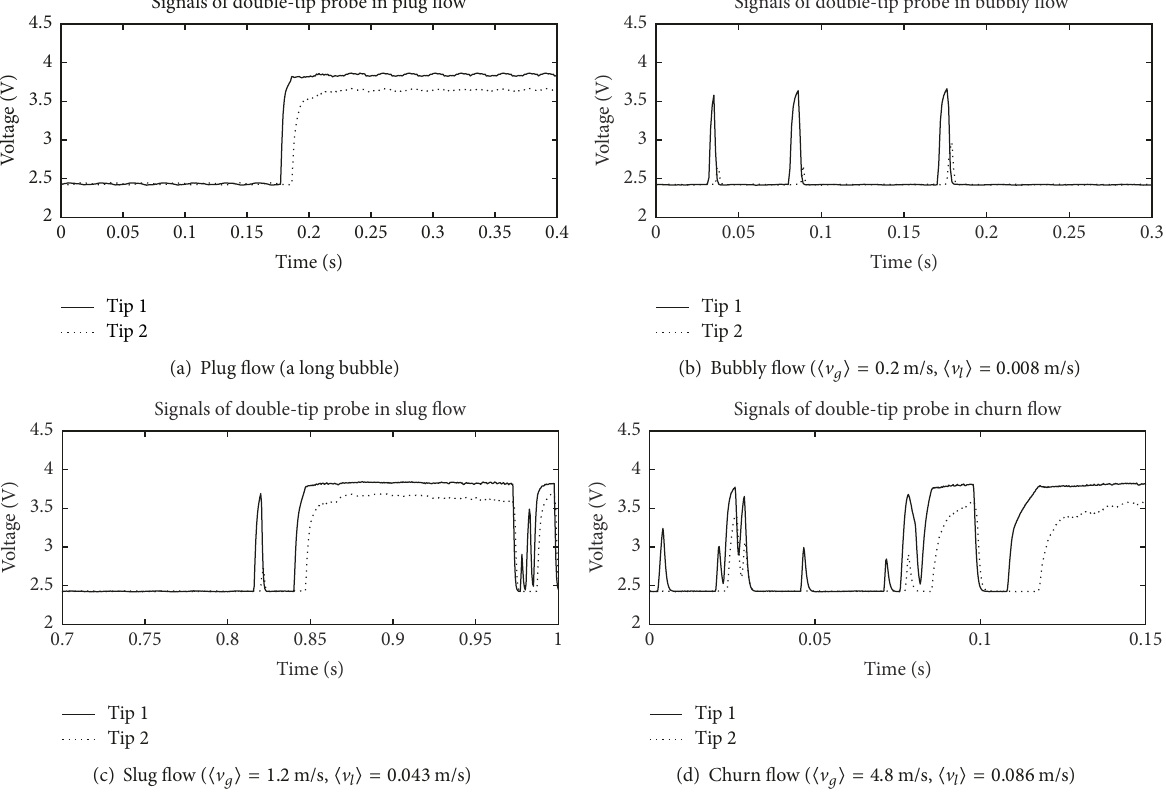
Figure 17: Double-tip signals for various flow